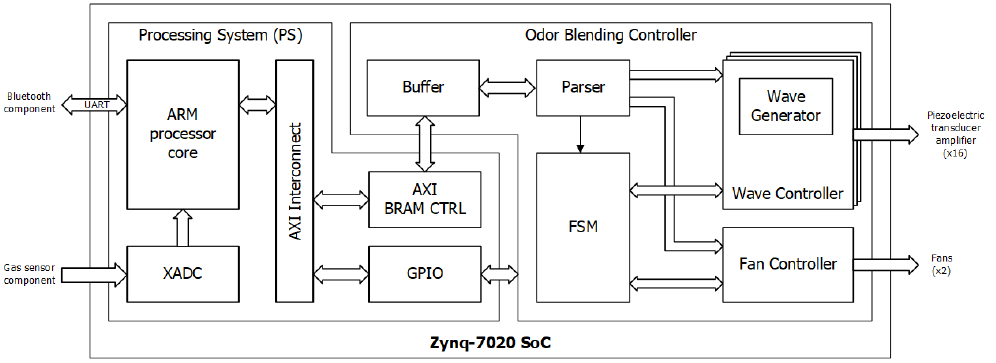
Figure 4. Firmware design in